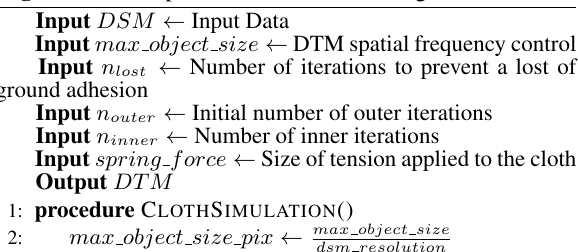
Algorithm 1 Proposed cloth simulation algorithm